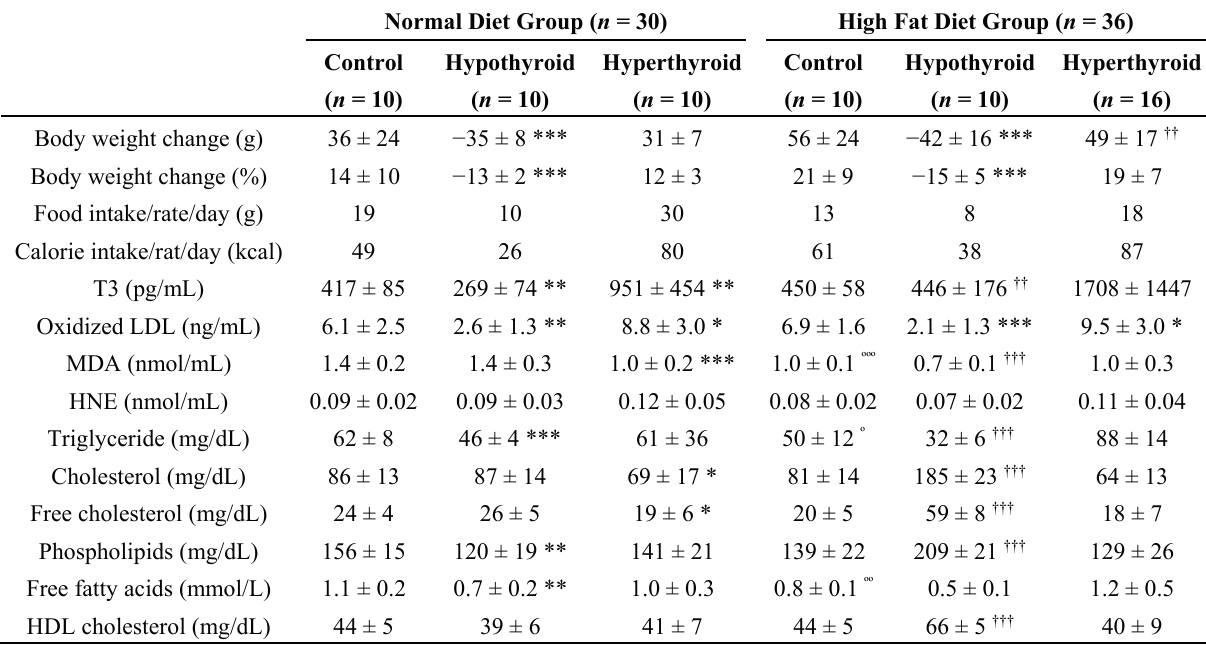
Table 1. Characteristics of female SD rats after a 12-week treatment.